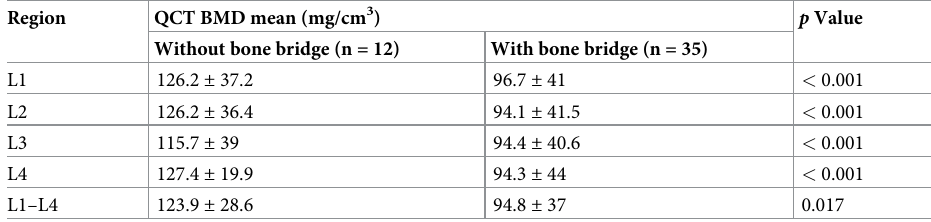
Table 3. BMD difference according to existence of bone bridge. Region